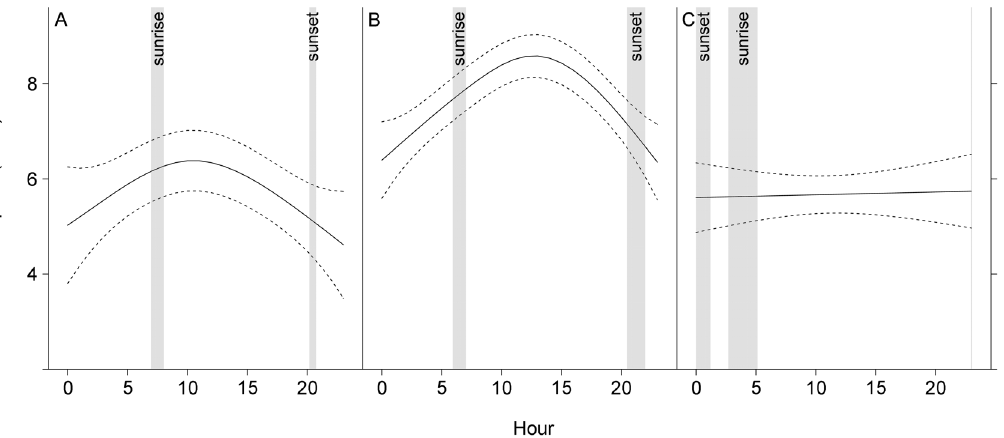
Figure 5. GAM estimate of transiting speed of fin whales during 24-hours in each geographic area. A. Azores area. B. area between 40 and 56 u N. C. area north of 56 u N. Solid line represents the estimate and dashed lines the estimate 6 2 SE. Grey areas correspond to sunrise and sunset